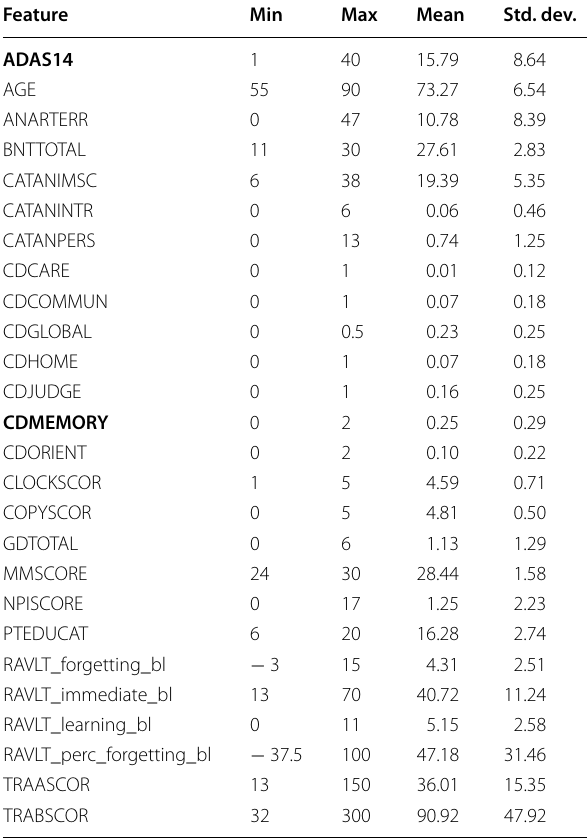
Table 2 Descriptive statistics for the ordinal data of all subjects